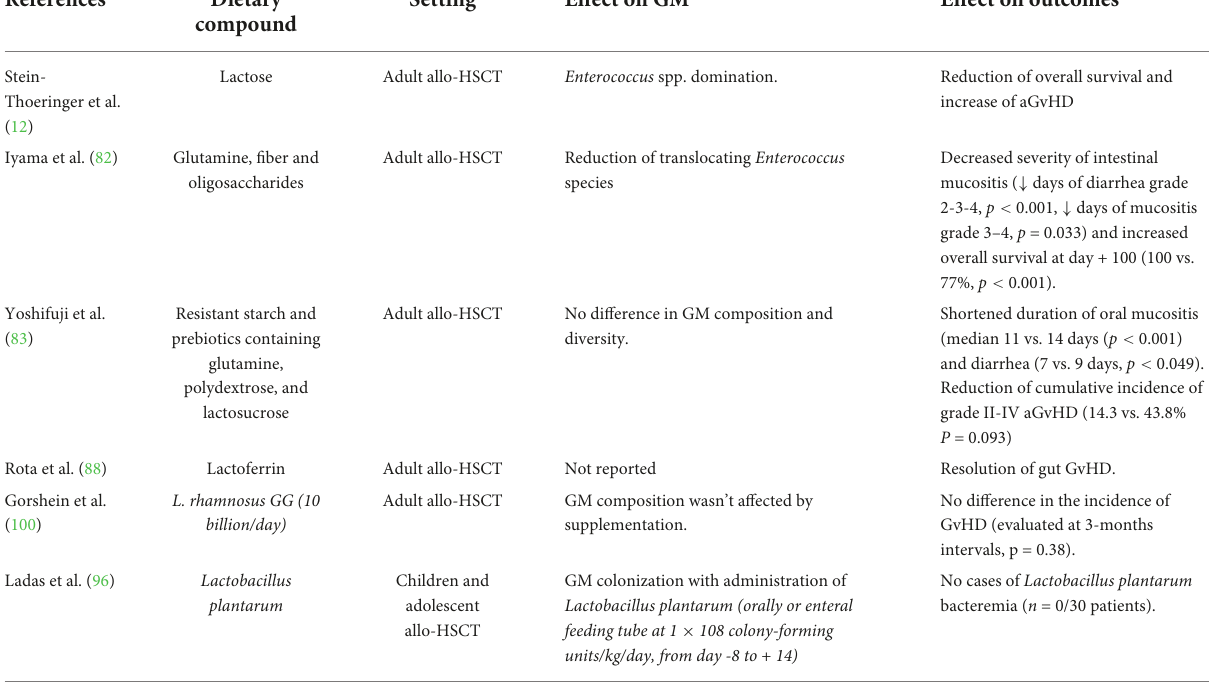
TABLE 1 Summary of the main studies on GM modulation in